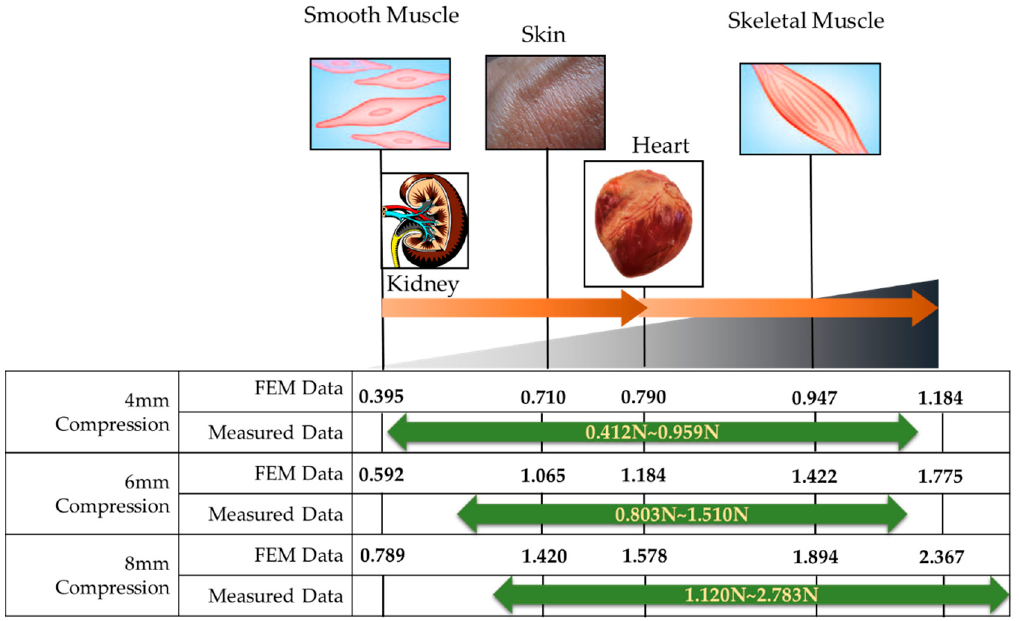
Figure 13. Comparative schematic of human tissues between calculation and measurement.